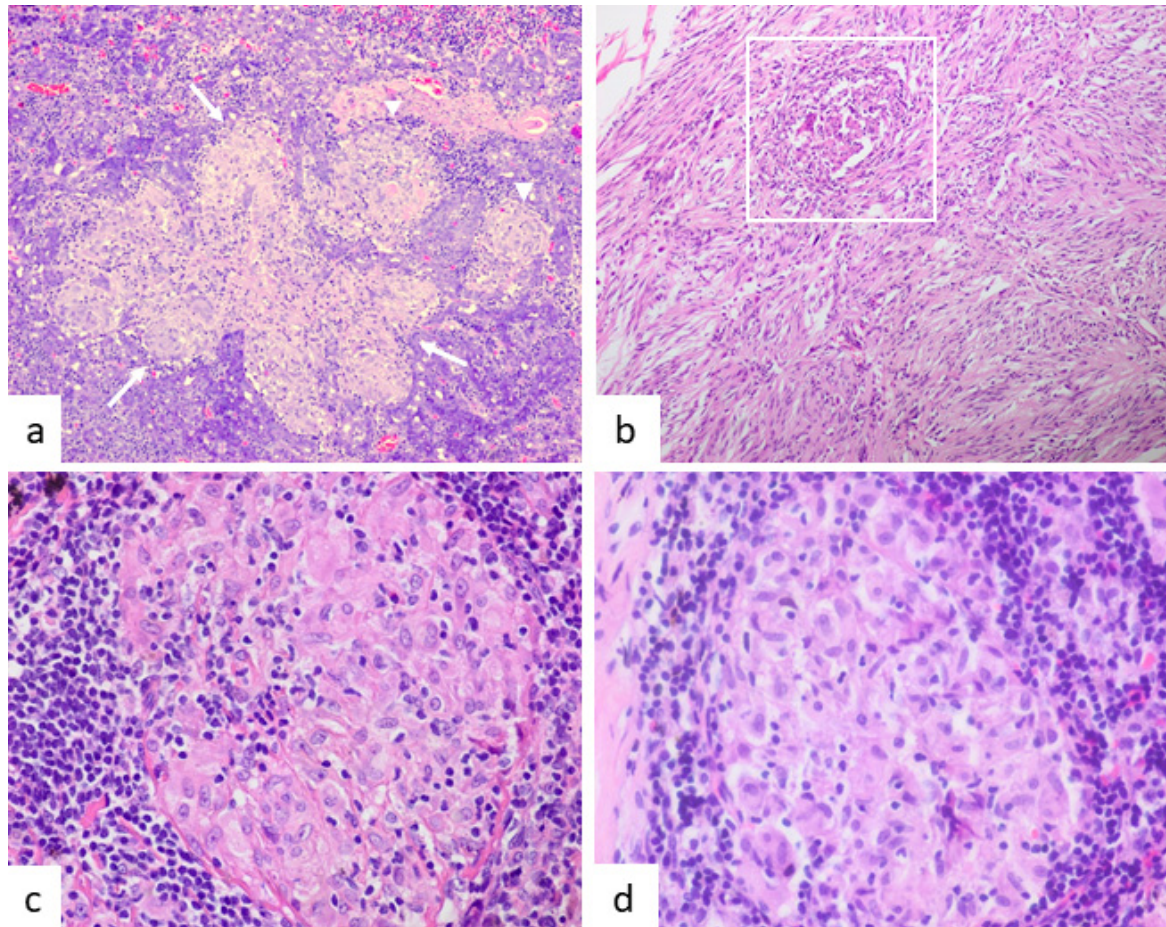
Figure 5. ( a ) Intratumoral granulomas were abundant in the case of acinic cell carcinoma of the parotid gland (case 1). A confluent granuloma (marked by three arrows) and two single granulomas (head arrows) are evident (HE, ×200). ( b ) In contrast, GIST showed a single intratumoral granuloma (white square) (HE, ×200). (HE, ×600). ( c , d ) Mediastinal lymph node from a patient with rectal adenocarcinoma (case 9) ( c ) and from a patient with sarcoidosis and no neoplasm ( d ). In both cases, morphology is similar, showing non-necrotizing, epithelioid granulomas with admixed lymphocytes (HE, ×400). Table 1. Main clinicopathological features of patients with systemic sarcoidosis and preceding TAGs.